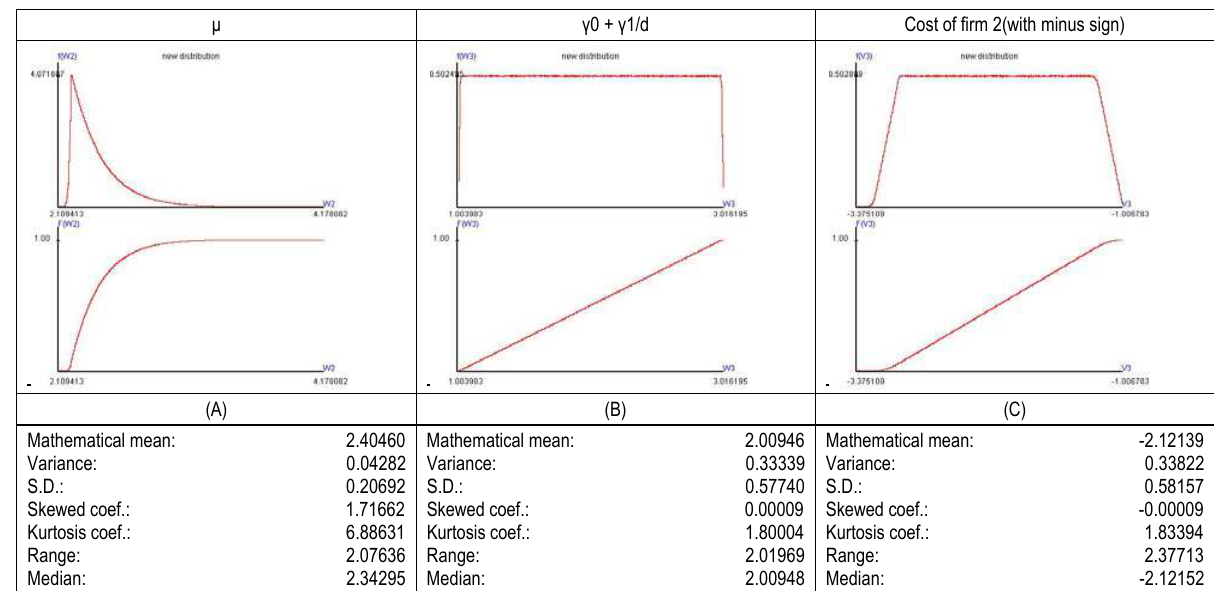
Table 3. Cost structure of firm 2